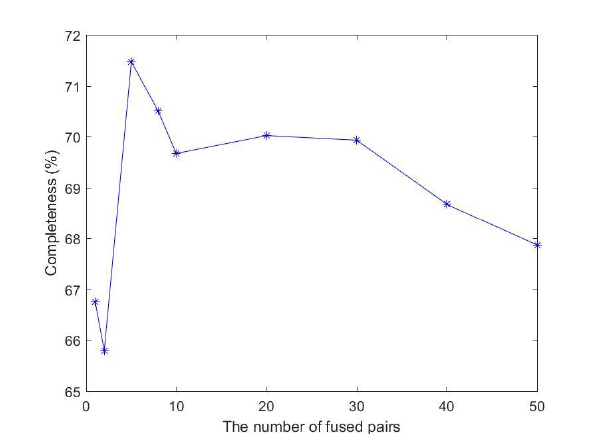
Figure 6. Relation between the completeness and the number of fused stereo image pairs